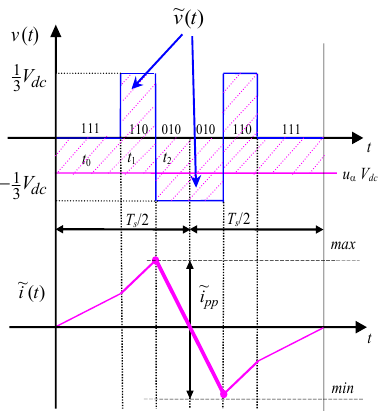
Figure 12. Output voltage and current ripple for DPWM+ technique in one switching period (sector II, − 1/3 ≤ u α ≤ 0).